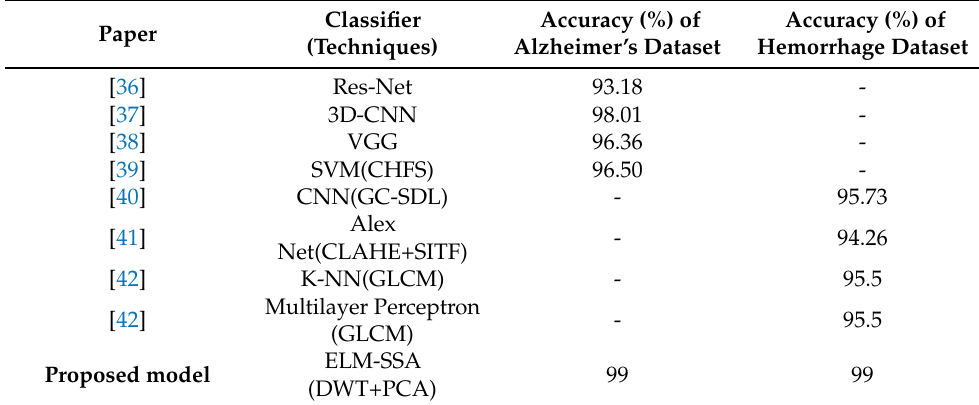
Table 7. Comparison of classification Accuracy of ELM-SSA model with other models using Alzheimer’s and Hemorrhage Datasets.